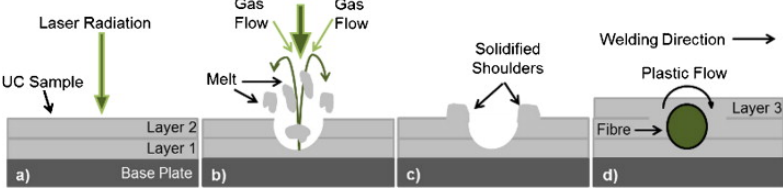
Figure 10. Channels created by manipulation of laser/material and assist gas interaction [40]. ( a ) Laser radiation; ( b ) Spatter/melt formation; ( c ) Channel creation; ( d ) Fiber embedding